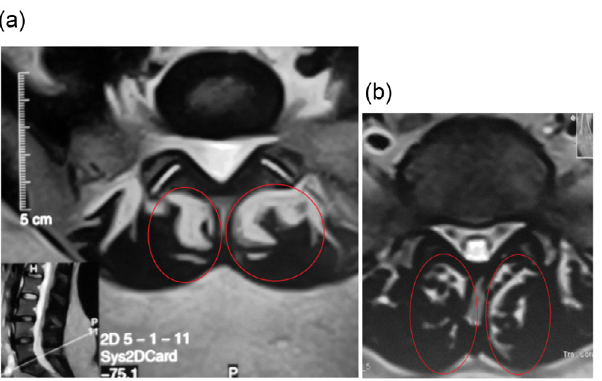
Figure 4. (a) Axial view of lumbar spine MRI shows severe multifidus atrophy, fatty degeneration (high signal intensity) is more than 50% (red circle), (b) axial view of the same patient after 15 months post-injection of PLRP into atrophied lumbar multifidus with decreased fatty degeneration.